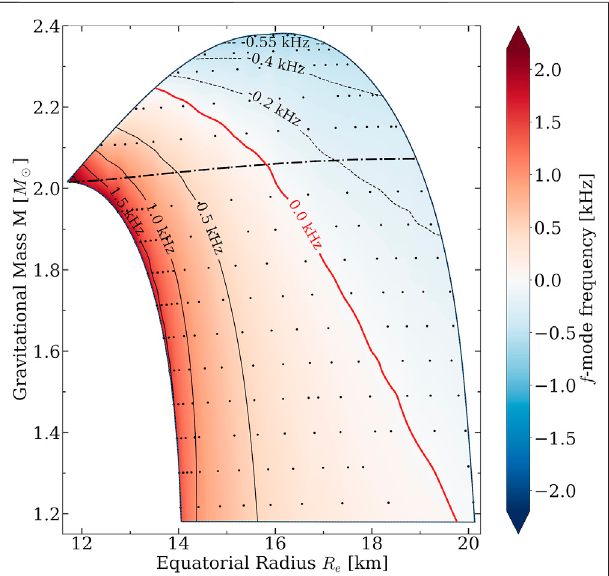
FIGURE 4 | The frequency of the 2 f 2 -mode for the entire EoS H4 is displayed color coded and some contour lines are shown. Each black dot indicates a neutron star model for which we have calculated its nonaxisymmetric mode frequencies. All neutron stars located above the (nearly horizontal) dash-dotted line are supramassive. The red (thick) contour line at 0.0 kHz separates the stable models from those that are susceptible to the CFS-instability. Figure taken from Krüger and Kokkotas (2020a) with permission by